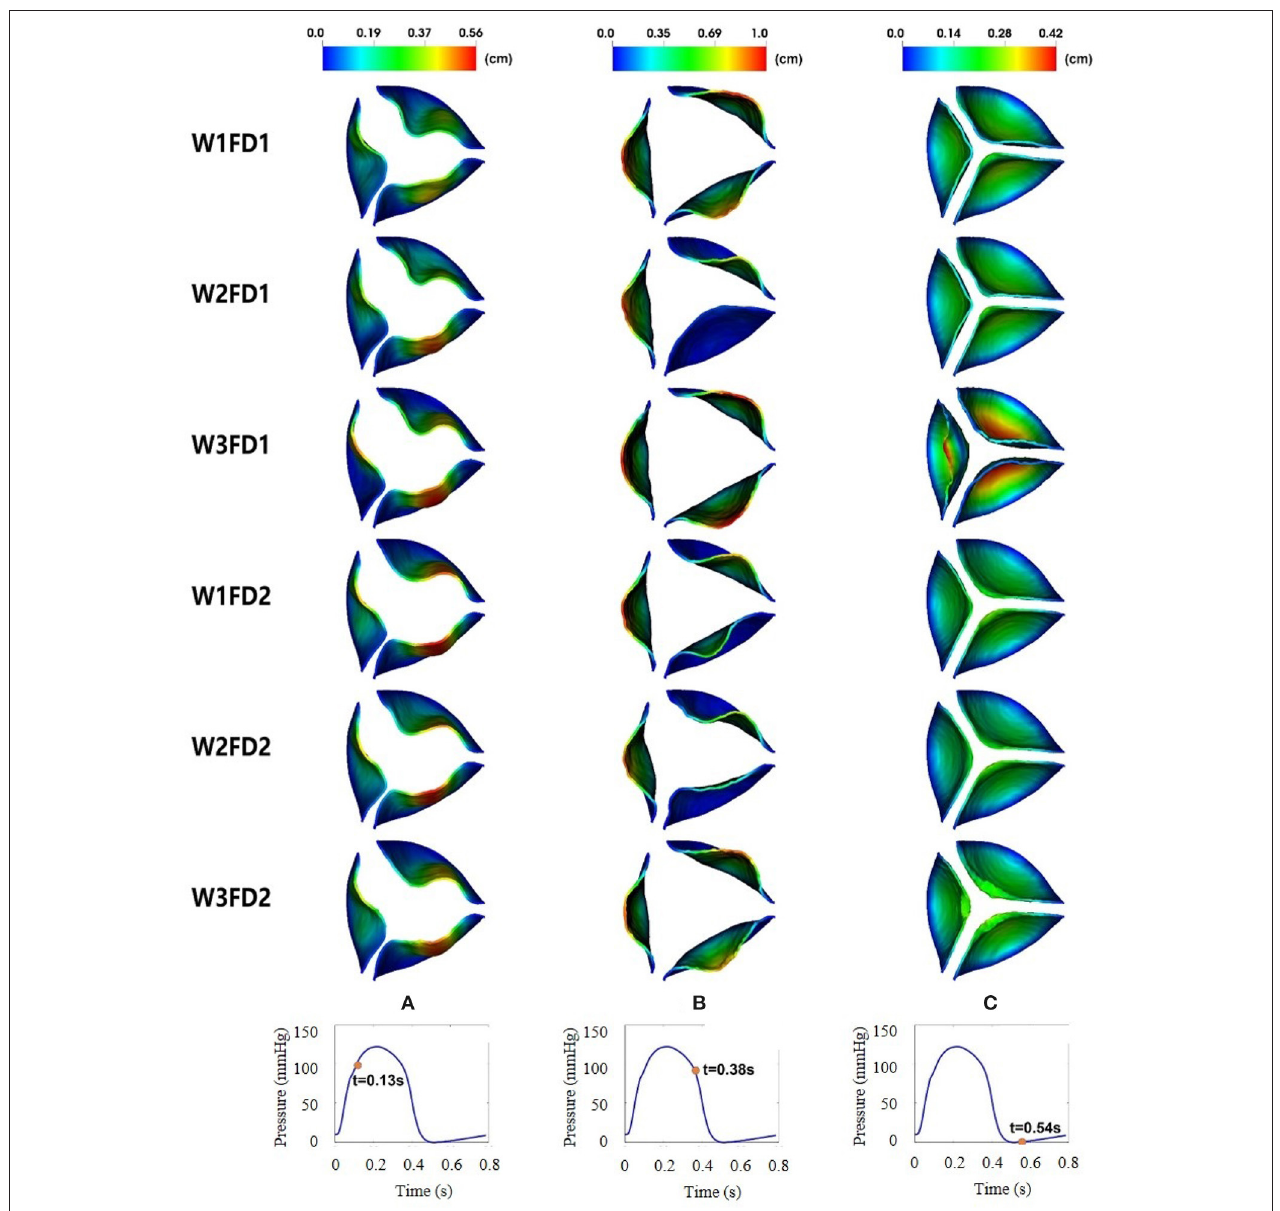
FIGURE 6 | Dynamic deformation of the AV leaflets for the six cases at different time. The time points from left to right are 0.13 (A) , 0.38 (B) , and 0.54s (C)